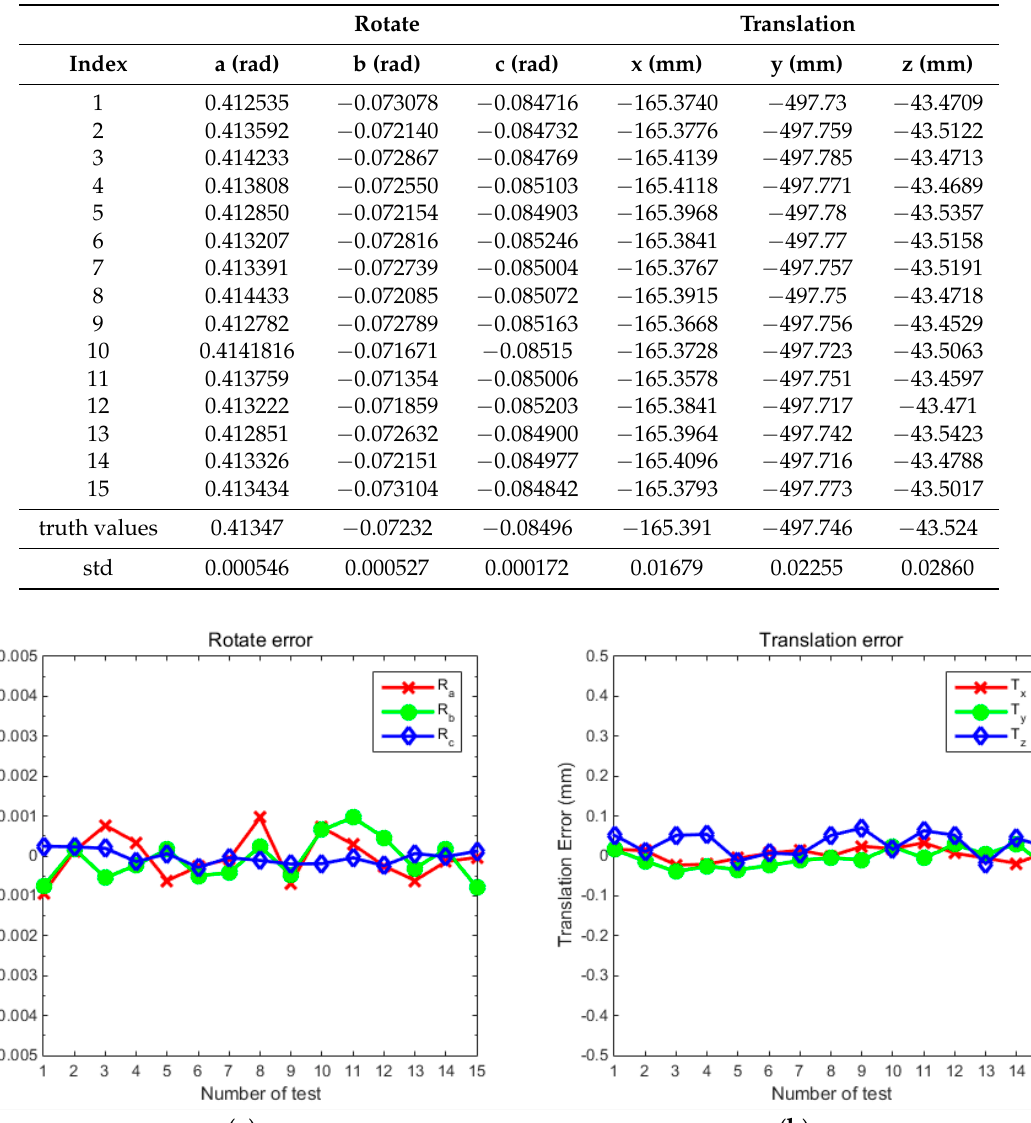
Table 5. The experiment results and the truth value measured by a coordinate measuring machine.